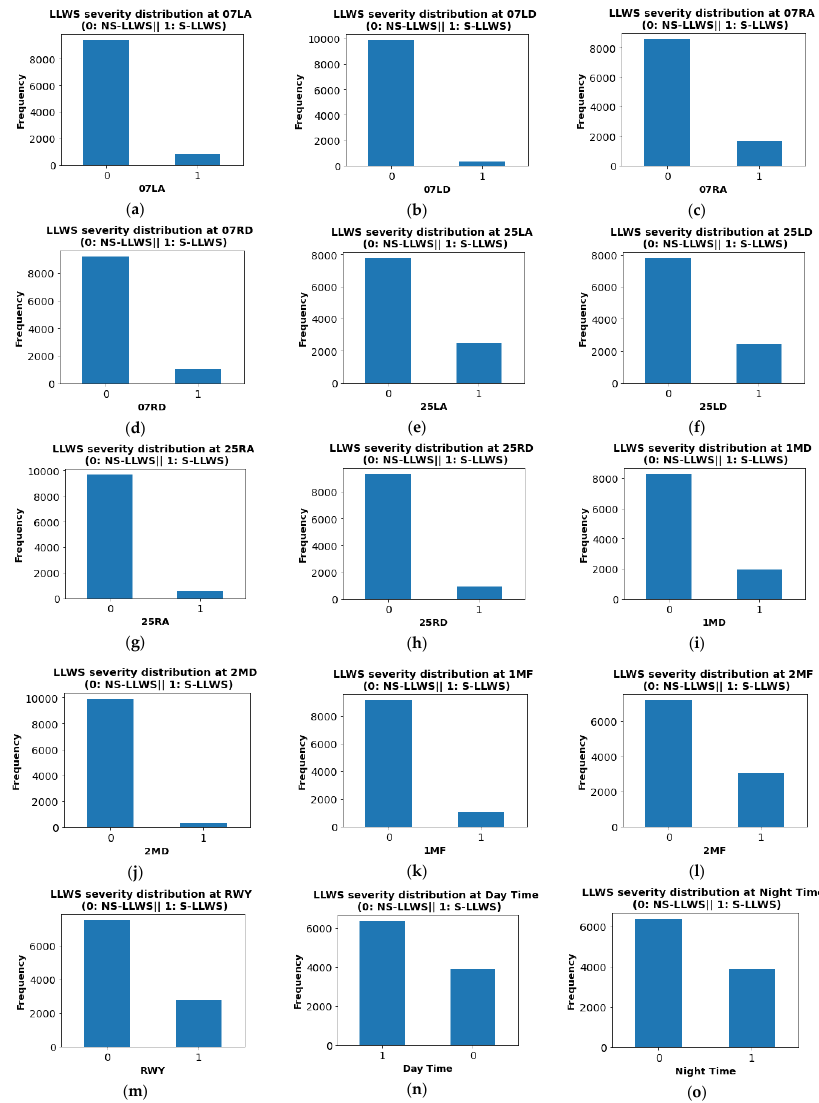
Figure 5. LLWS events distribution: ( a ) Frequency of S-LLWS and NS-LLWS at Runway 07LA, ( b ) Frequency of S-LLWS and NS-LLWS at Runway 07LD, ( c ) Frequency of S-LLWS and NS-LLWS at Runway 07RA, ( d ) Frequency of S-LLWS and NS-LLWS at Runway 07RD, ( e ) Frequency of S-LLWS and NS-LLWS at Runway 25LA, ( f ) Frequency of S-LLWS and NS-LLWS at Runway 25LD, ( g ) Fre- quency of S-LLWS and NS-LLWS at Runway 25RA, ( h ) Frequency of S-LLWS and NS-LLWS at Run- way 25RD, ( i ) Frequency of S-LLWS and NS-LLWS at 1MD from Runway, ( j ) Frequency of S-LLWS and NS-LLWS at 2MD from Runway, ( k ) Frequency of S-LLWS and NS-LLWS at 1MF from Runway, ( l ) Frequency of S-LLWS and NS-LLWS at 2MF from Runway, ( m ) Frequency of S-LLWS and NS- LLWS at RWY, ( n ) Frequency of S-LLWS and NS-LLWS during day time, ( o ) Frequency of S-LLWS and NS-LLWS during night time.